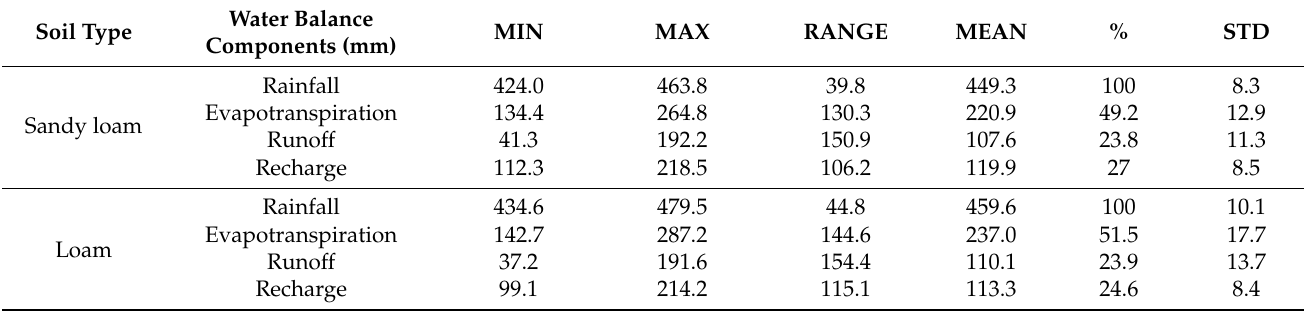
Table A2. Average annual water balance components as a function of soil